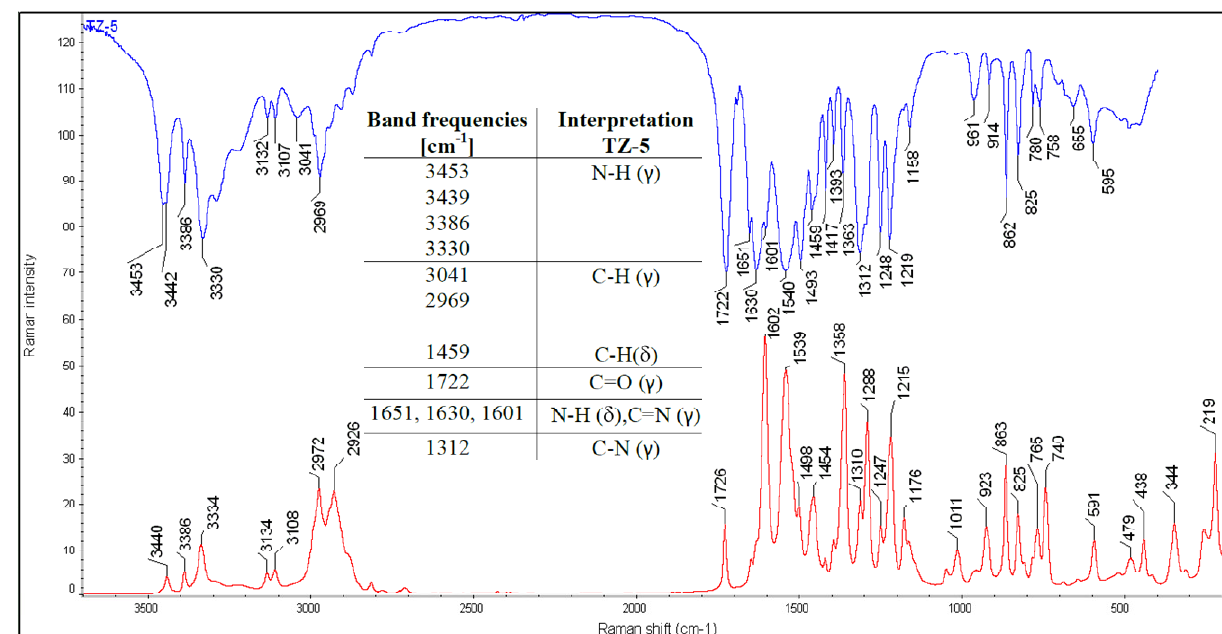
Figure 3. IR and Raman spectra of TZ-5